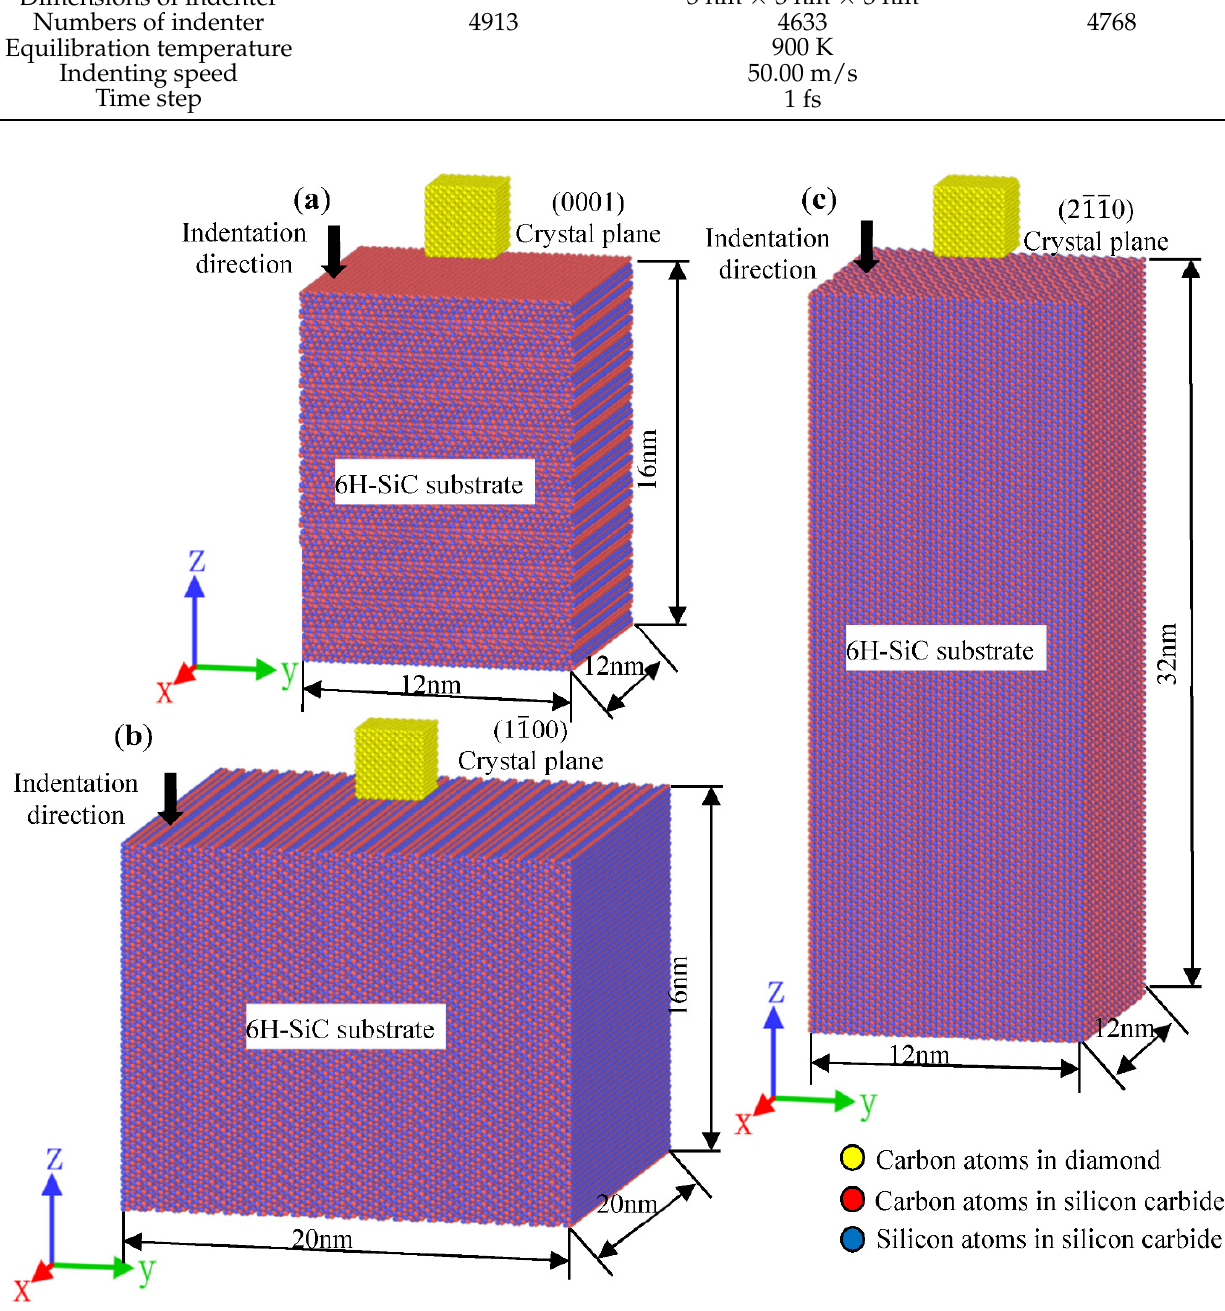
Figure 1. Molecular dynamics model of nanoindentation on different faces of 6H-SiC substrate.